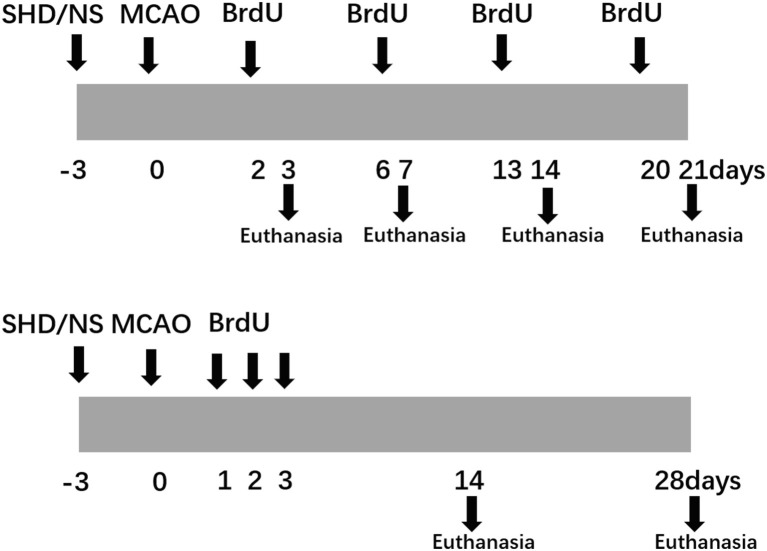
Flow chart of the experimental protocols.